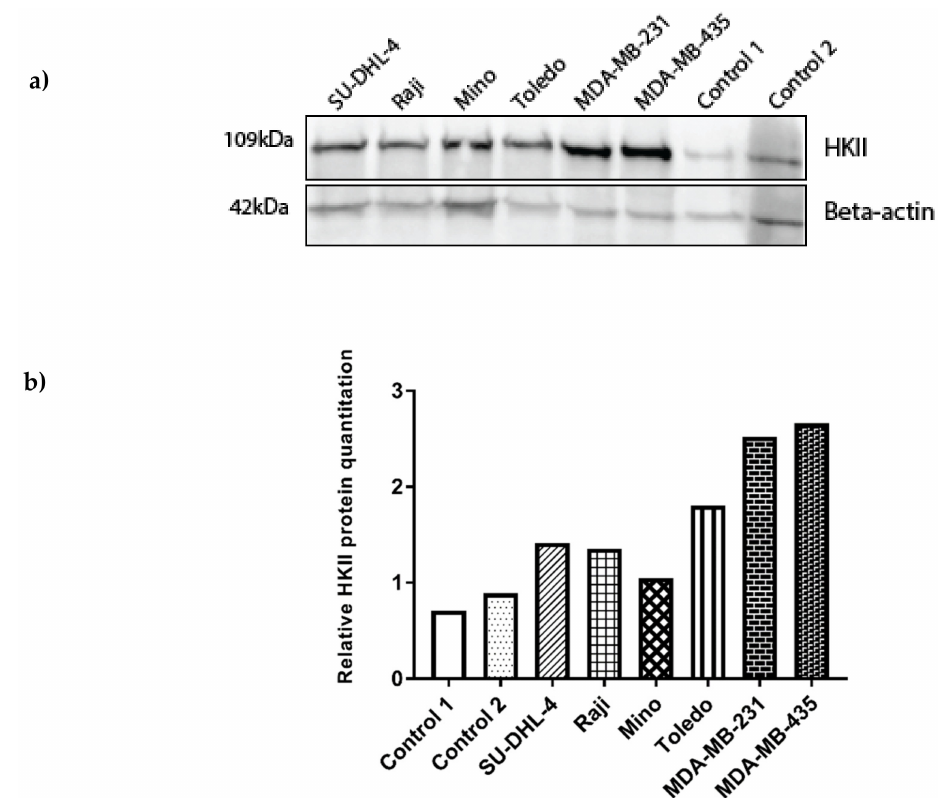
Figure 3. HKII protein detection. Western blot analysis of HKII protein (109kDa) expression in NHL (SU-DHL-4, Raji, Mino, Toledo), breast cancer (MDA-MB-231) and melanoma (MDA-MB-435) cell lines compared to healthy control subjects 1 and 2. 30 µ g total protein was loaded and samples were normalised against the Beta-actin (42kDa) loading control. ( a ) The HKII protein levels were increased in all four NHL cell lines compared to healthy control subjects 1 and 2, and decreased when compared to the breast cancer (MDA-MB-231) and melanoma (MDA-MB-435) cells. ( b ) HKII protein quantitation analysis compared the normalised intensity ratios between samples and showed the breast cancer (MDA-MB-231) and melanoma (MDA-MB-435) cells to have increased HKII levels as compared to NHL cells and healthy control subjects 1 and